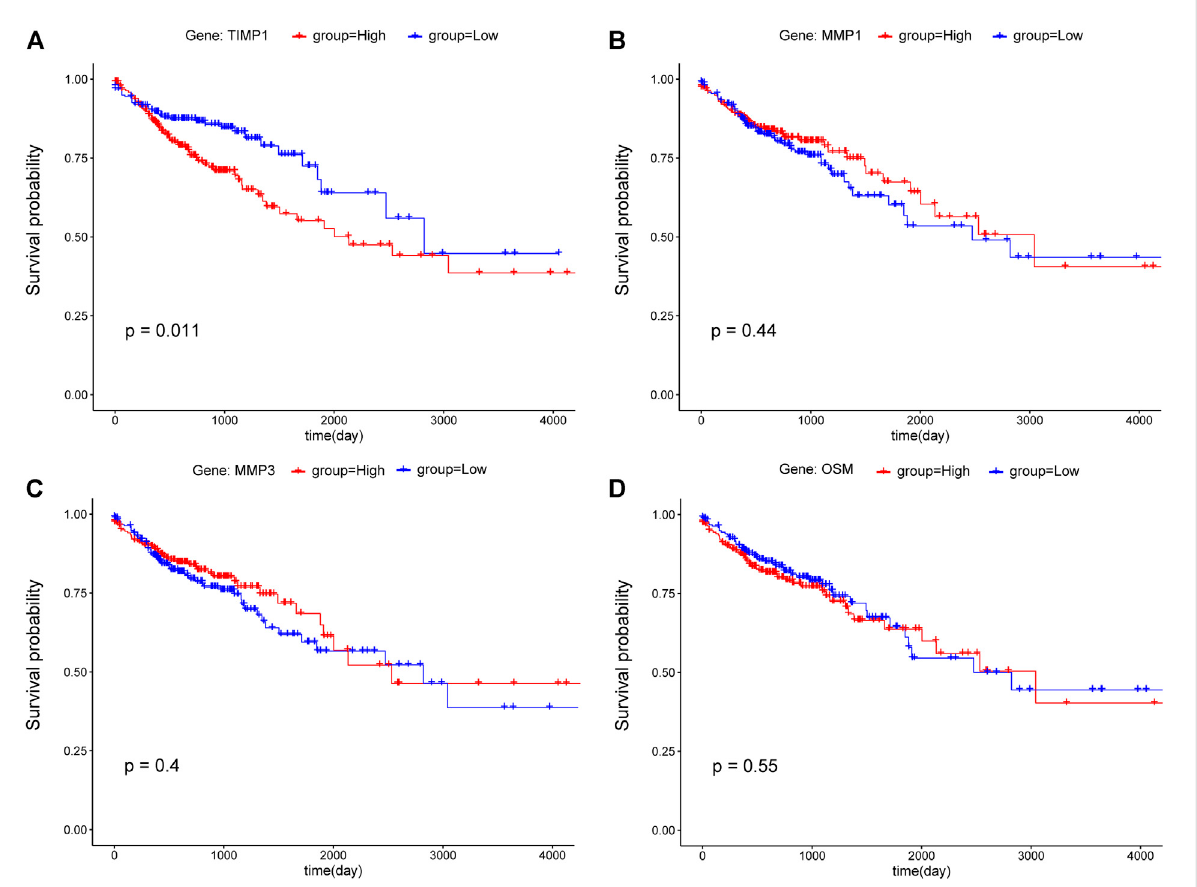
FIGURE 6 Kaplan-Meier survival curves of CRC patients for the top four hub genes including (A) TIMP1 , (B) MMP1 , (C) MMP3 , and (D) OSM . According to the median value, gene expression was divided into two groups (red: high; blue: low), and the p -value < 0.05 was considered statistically signi fi